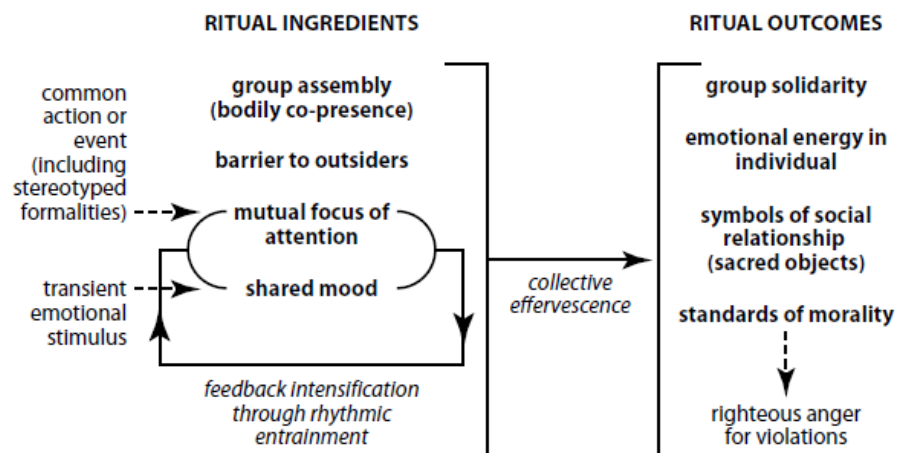
Figure 1. Interaction Ritual Chains (Collins 2004, p. 48). Reproduced with permission.